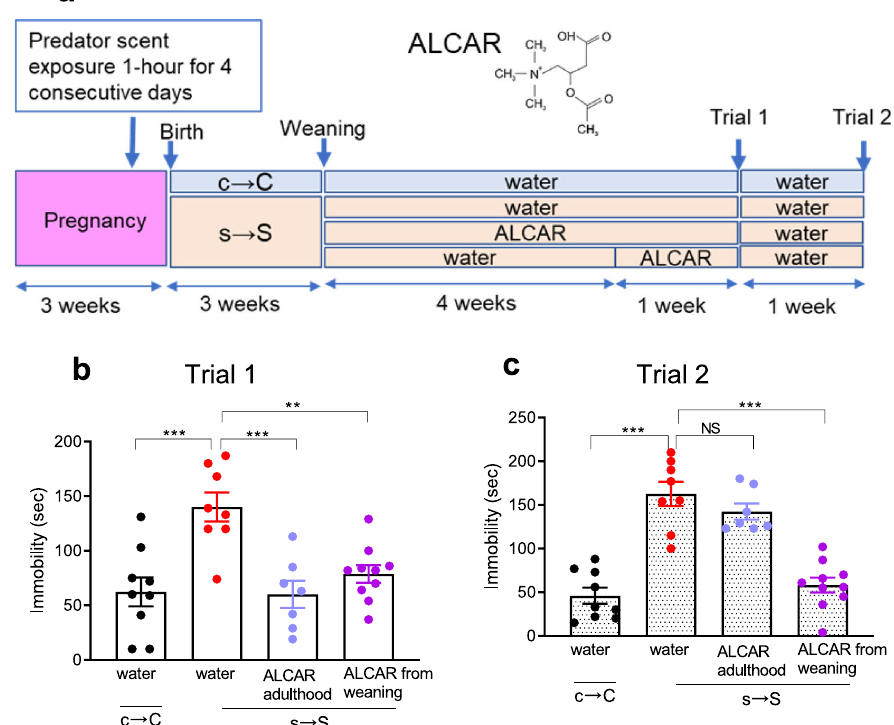
Fig. 6 Acetyl-L-carnitine (ALCAR) reverses depressive-like behavior after its cessation. a Schematic of the two ALCAR administration regimes, and the chemical structure of ALCAR. b Time mice spent immobile in the forced swim assay following the treatment of ALCAR for 5 weeks from weaning, and 1 week during the adult stage, ( n = 9 c → C, 8 s → S, 7 s → S + ALCAR from Weaning, 10 s → S + ALCAR in Adulthood). One-way ANOVA: treatment effect ( F 3,30 = 9.72, P = 0.0001) followed by Tukey post hoc test, ** P < 0.01, *** P < 0.001, ns not signi fi cant ( P > 0.05). c Time mice spent immobile in the forced swim assay 1 week after the cessation of ALCAR treatment, One-way ANOVA revealed a signi fi cant treatment effect ( F 3,30 = 32, P = 0.0001) followed by Tukey post hoc test, *** P < 0.001, ns not signi fi cant ( P > 0.05). Data are presented as means ± S.E.M.